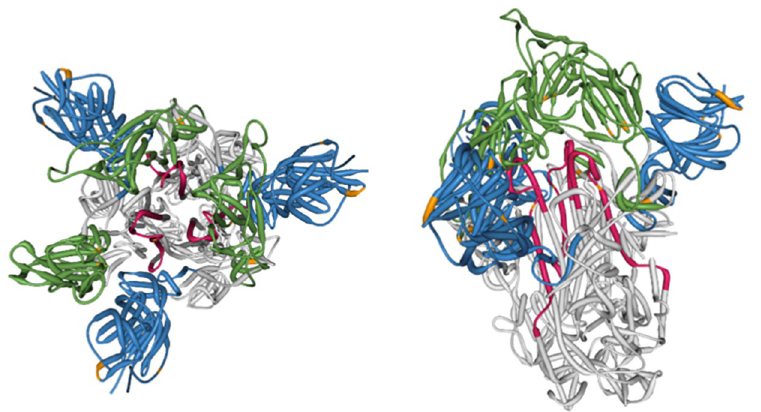
Fig 6. Spike protein crystal structure annotation 6CRZ (https://www.rcsb.org/structure/6CRZ) with MEME sites, a measure of episodic selection (These sites are listed in Table 4). The color legend for these figures is as follows: the N-Terminal domain (NTD) region is highlighted in Blue, the Receptor binding domain (RBD) region is highlighted in Green, The Heptad Repeat (HR) region is highlighted in Ruby, MEME (Positively selected) sites are highlighted in Orange. To interact with the figure above visit: https://observablehq.com/@aglucaci/categorical-ngl-rascl-mu.